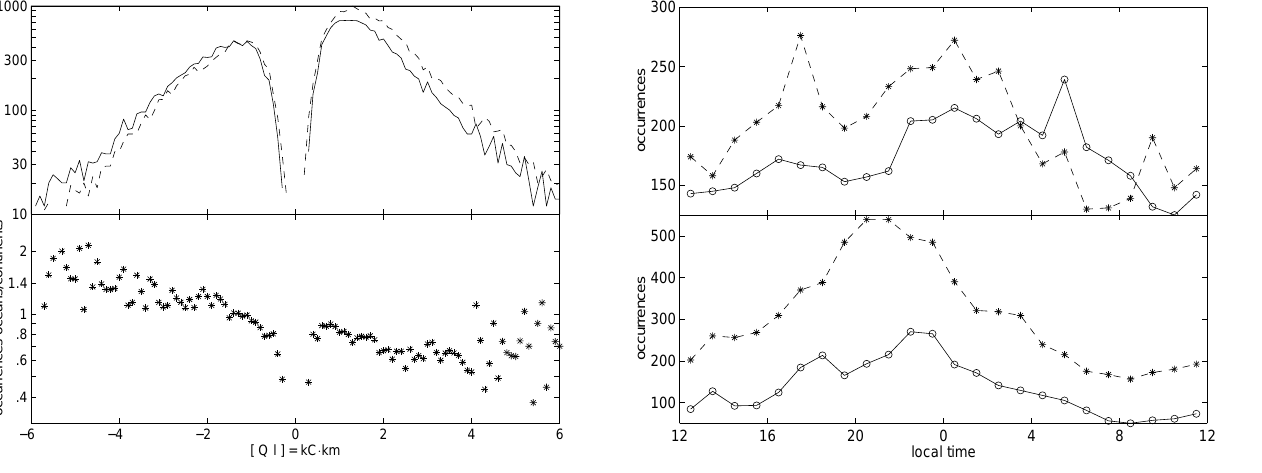
Fig. 4. The diurnal variation of negative (solid lines) and positive (dashed lines) lightning discharge occurrences over the oceans (up- per panel) and the continents (lower panel) are similar except for negative oceanic lightning discharge